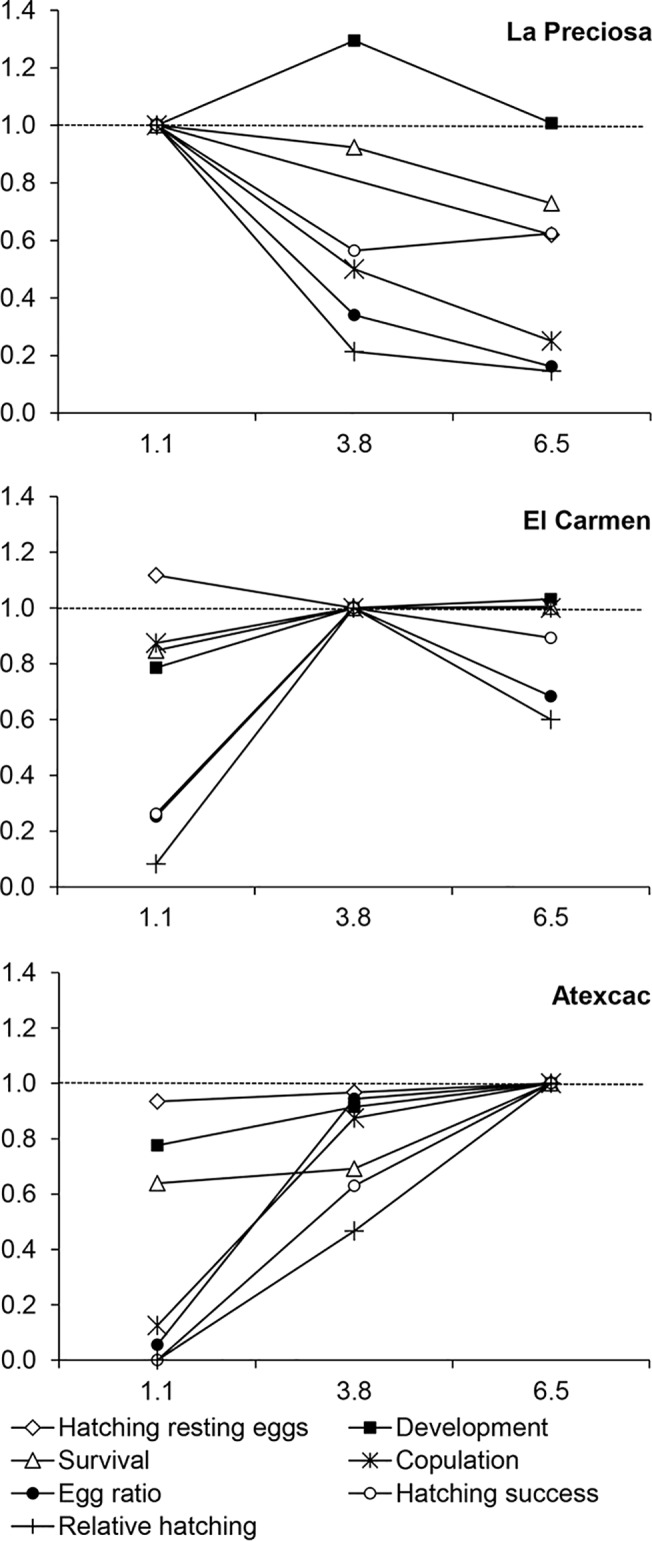
Performance of populations of L. cf. sicilis at alternate salinities relative to home conditions.Fitness at home conditions = 1, pointed line.